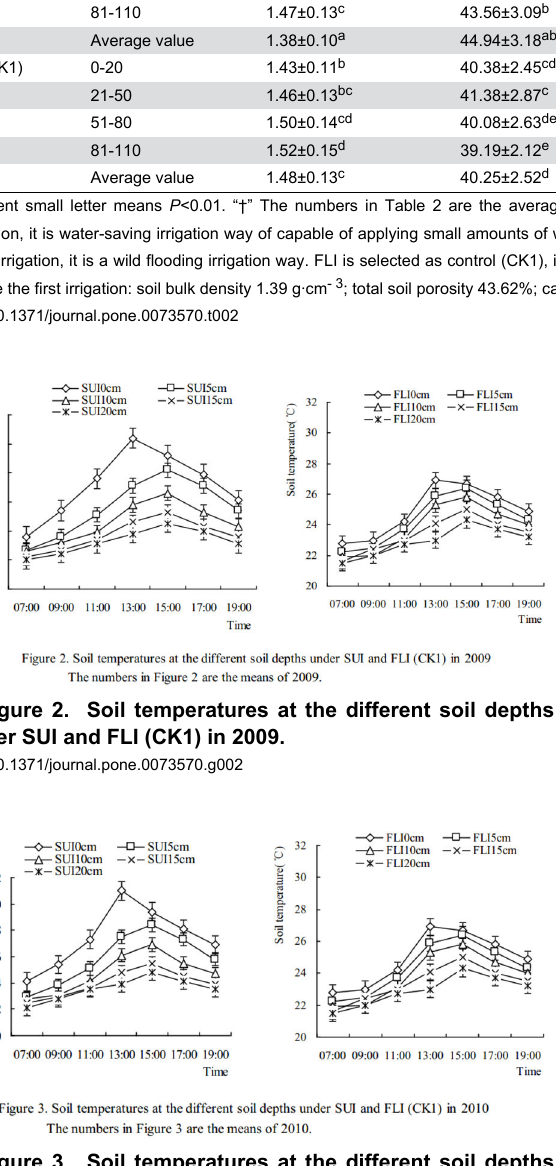
Figure 3. Soil temperatures at the different soil depths under SUI and FLI (CK1) in 2010.